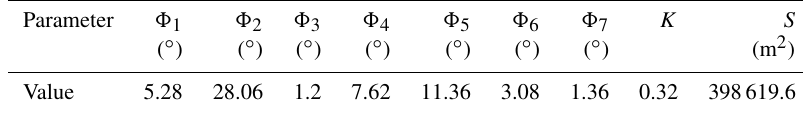
Table 2. Geometric parameters of the flowslide (angle).